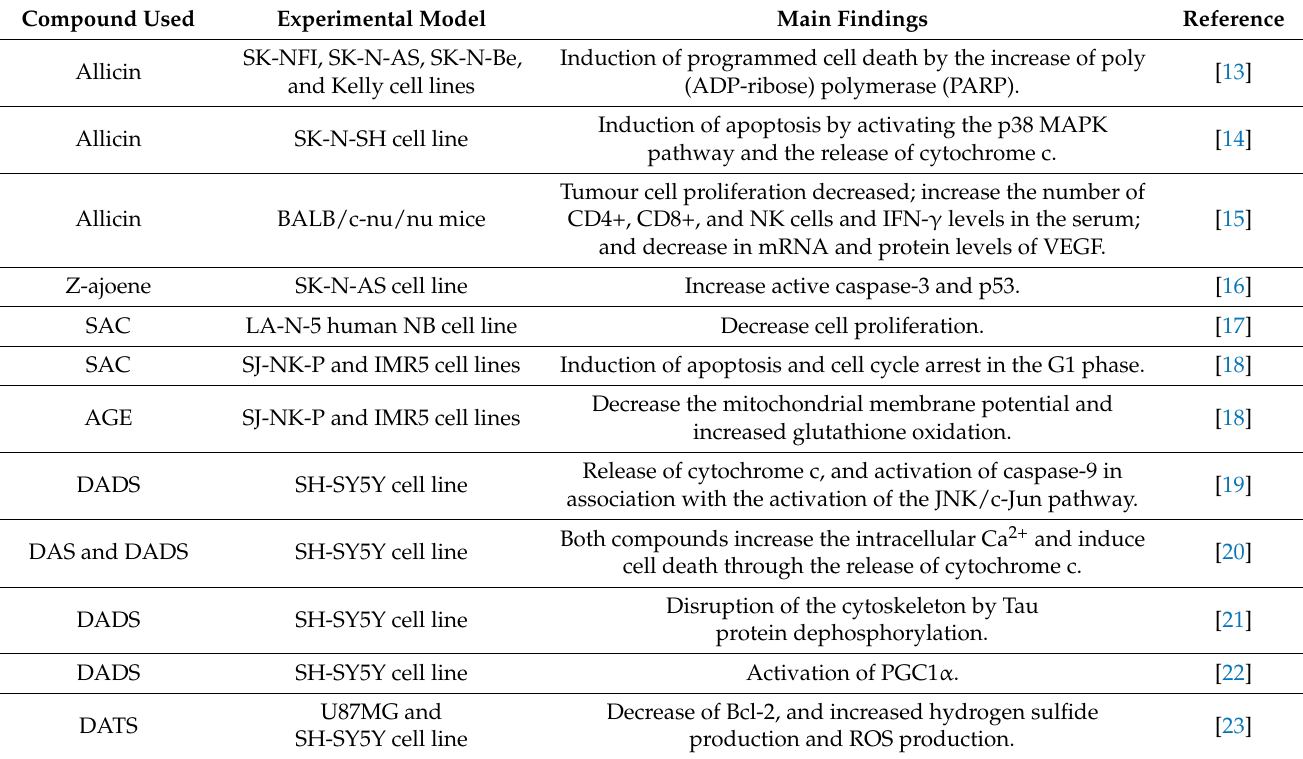
Table 1. Effect of aged garlic extract (AGE) and garlic compounds on neuroblastoma. Main Findings